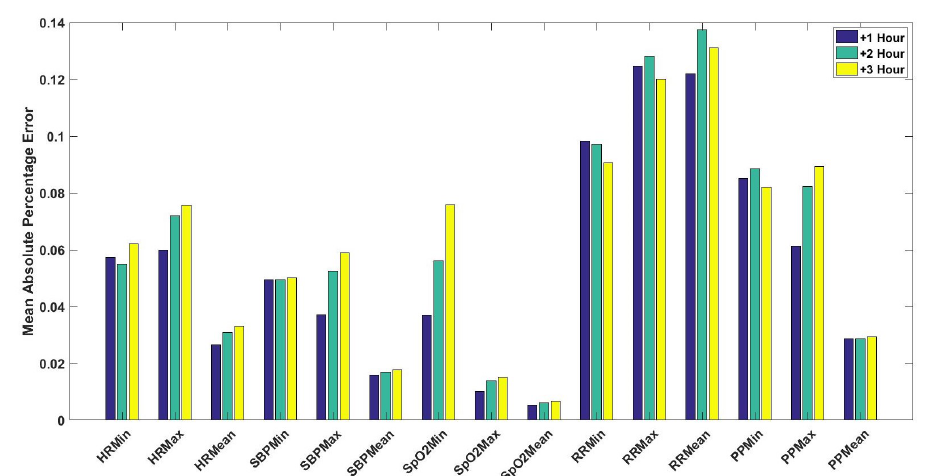
Figure 9. The mean absolute percentage error (MAPE) of the predicted statistical values (i.e., minimum, maximum, and mean) for the vital signs of HR, SBP, Sp O 2 , RR, and PP for the upcoming three hours ( + 1, + 2, + 3 h) for postsurgical